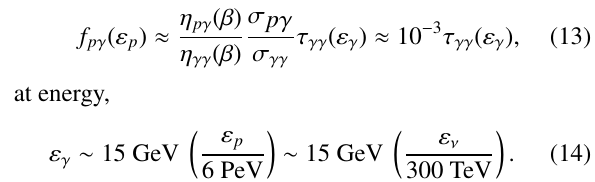
with σ γγ ∼ 0 . 1 σ T ∼ 10 − 25 cm 2 the Thompson cross- section and η γγ the integration constant of order unity. The ratio of optical depths from the two processes is